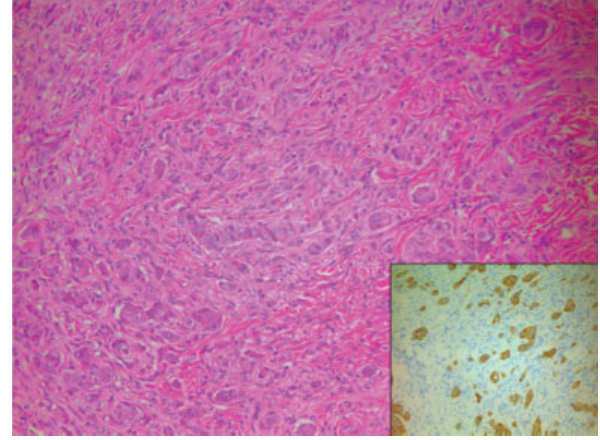
Fig. 2 H&E stain demonstrating in fi ltrating neuroendocrine cells and nests con fi rmed by positive synaptophysin staining (inset). H&E, hematoxylin and